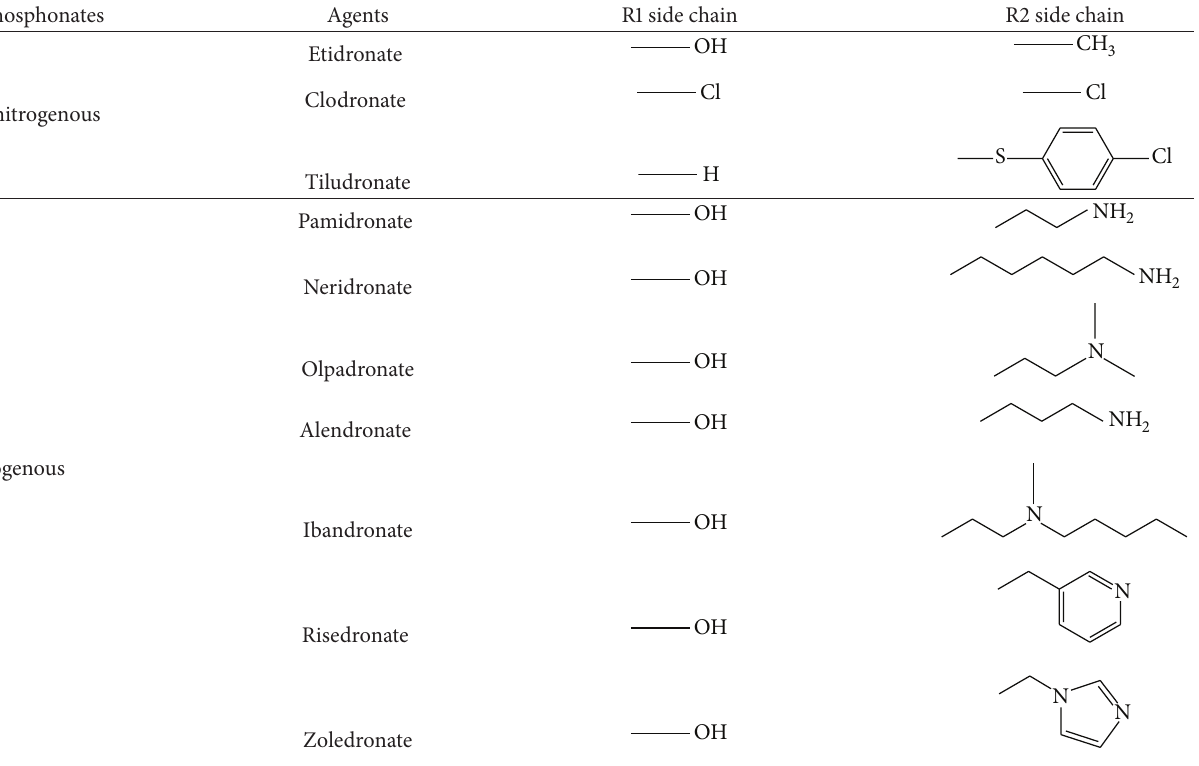
Table 2: Two classes of